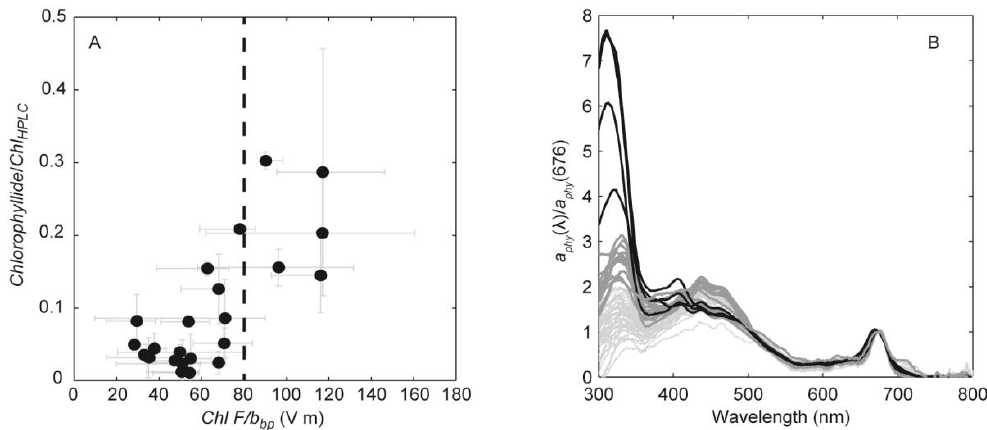
Figure 8. (a) Chlorophyllide concentration normalized to Chl HPLC (g/g) was greater at higher values of the optical community index. Bars are the range of individual samples within each profile (23 profiles, 60 HPLC samples). (b) Phytoplankton absorption coefficient, a phy , normalized to absorption at 676nm; all available data are shown for completeness ( n = 63). Large peaks near 300nm occurred when the optical community index exceeded 80Vm (dark gray and black lines); black lines note spectra with shifts in the absorption peak from 325–330 to 310–315nm.